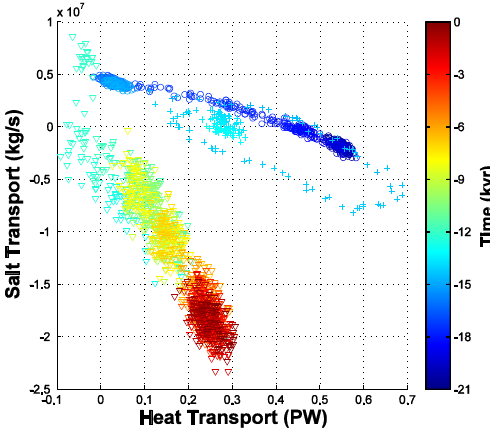
Figure 2. (a) TraCE-21K meridional heat (purple) and salt (green) transport between 30°S 2 and 0°. Positive values denote northward transport. The main climatic events in the last 3 deglaciation are also marked: Last Glacial Maximum (LGM), Heinrich event 1 (H1), Bølling- 4 Allerød (BA), Younger Dryas (YD) and Holocene. (b) Northward transport of heat (PW) and 5 (c) northward transport of salt (cm³/s), averaged for each key periods when freshwater was 6 injected into the ocean. 7